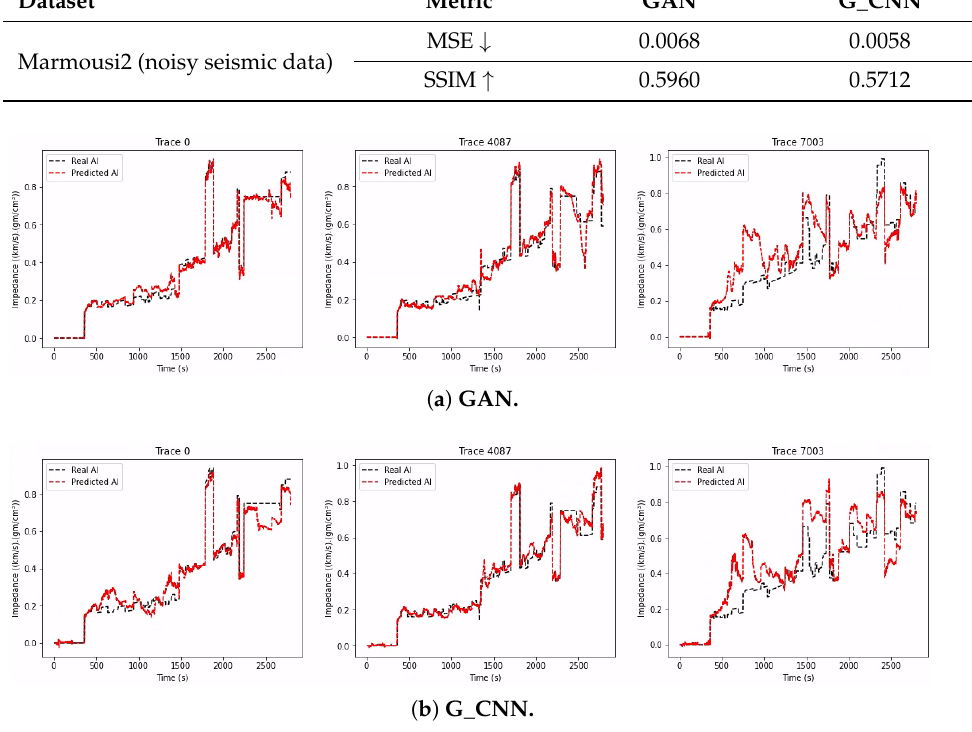
Figure 12. Prediction results for three seismic trace tests from the Marmousi2 dataset (with noisy